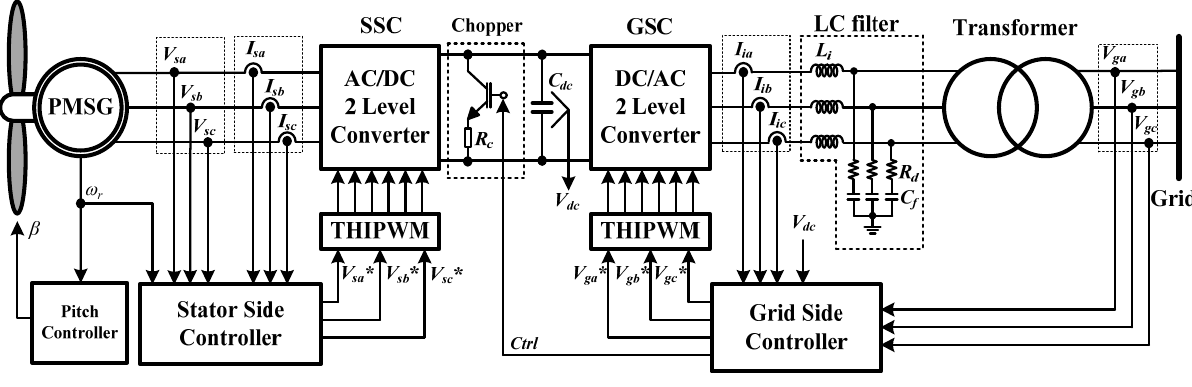
Figure 6. VSWT-PMSG control